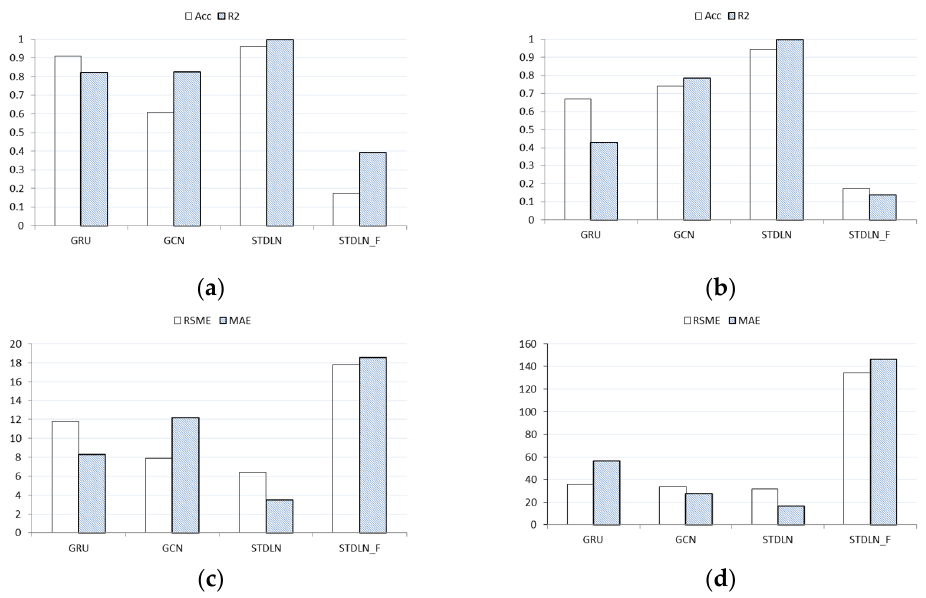
Figure 7. Performance comparison between deep learning networks. ( a ) The histogram of Acc and R 2 for the 5 min set; ( b ) The histogram of Acc and R 2 for the 15 min set; ( c ) The histogram of RSME and MAE for the 5 min set; ( d ) The histogram of RSME and MAE for the 15 min set.